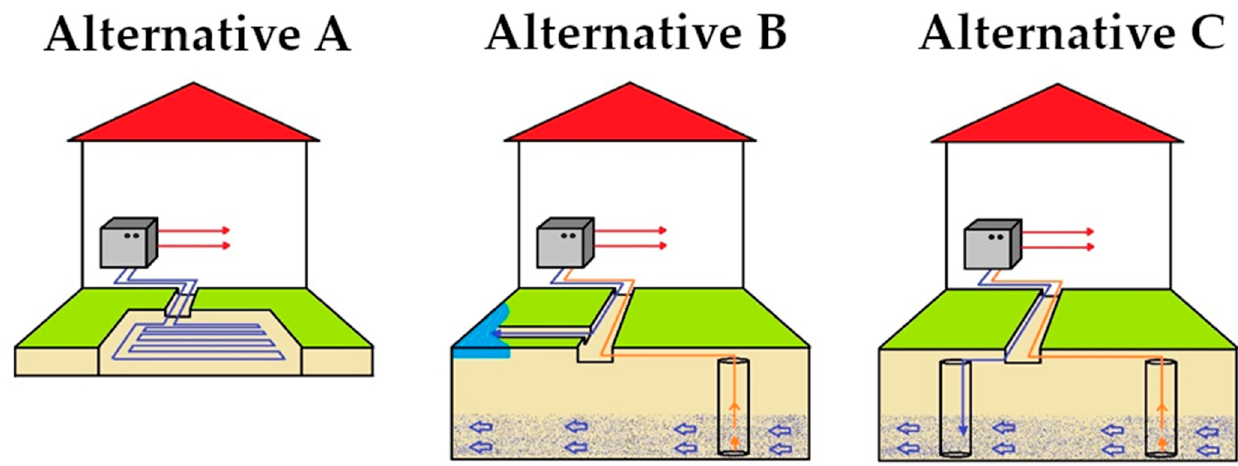
Figure 1. Sketch of the catchment